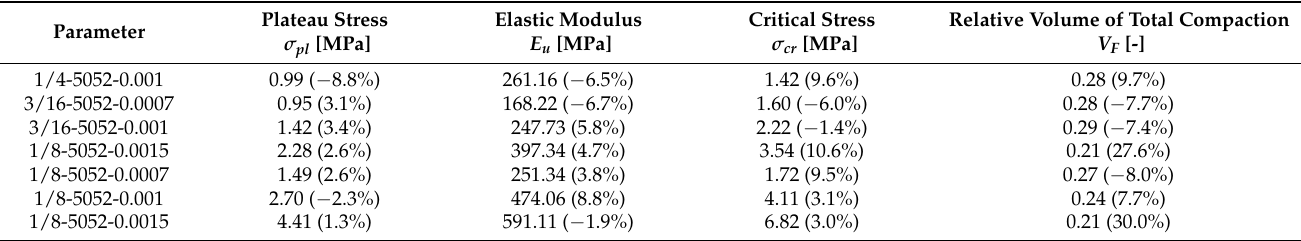
Table 6. List of the basic parameters of the examined